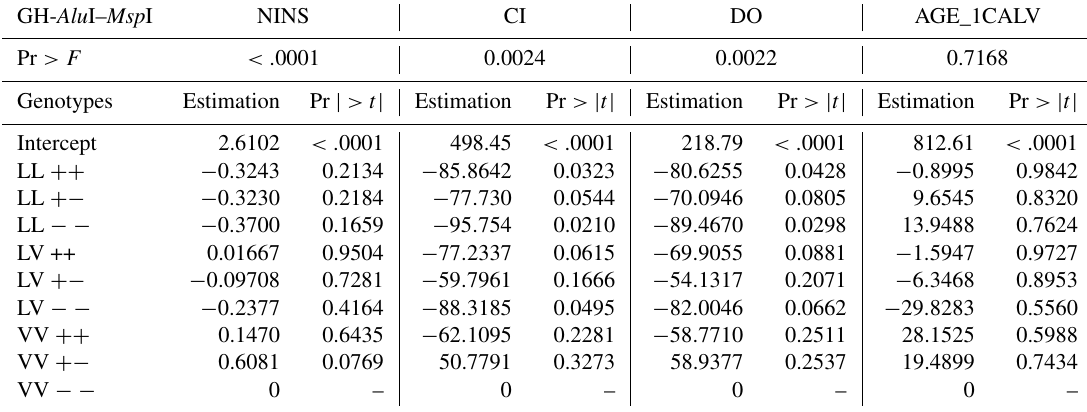
Table 6. The effect of combined genotypes on reproductive traits in dairy